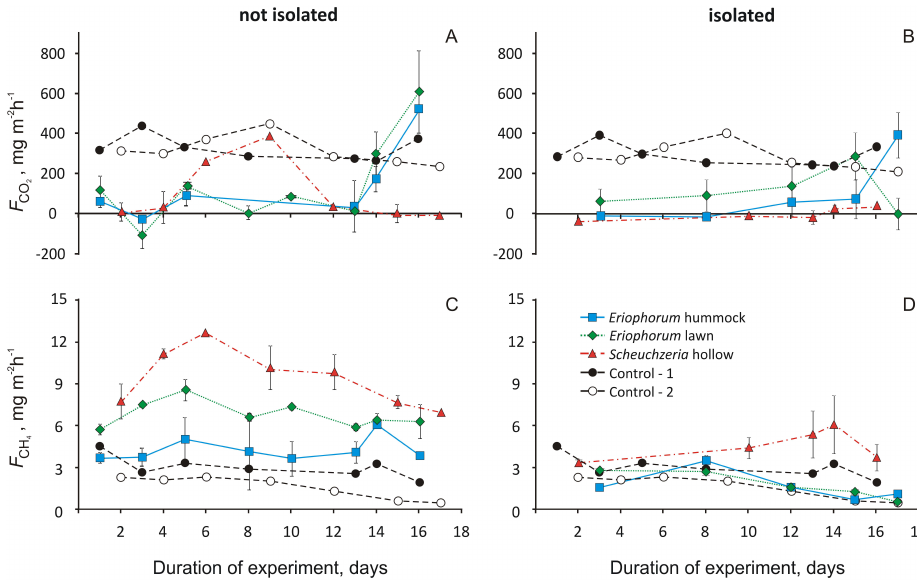
Fig. 2. Fluxes of carbon dioxide ( F CO ); (A, B) and methane ( F CH ); (C, D) from not isolated (A, C) and isolated (B, D) mesocosms 2 4 of E . vaginatum from hummocks and lawns, S. palustris from hollows and referenced cores without vascular plants during 18 days of the experiment. Errors are standard errors of measurement ( n = 3).